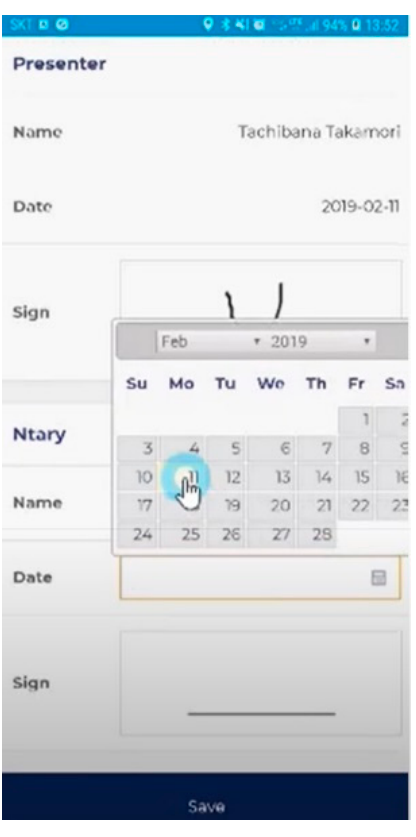
Figure 14. Legacy inheritance smart contract screen.